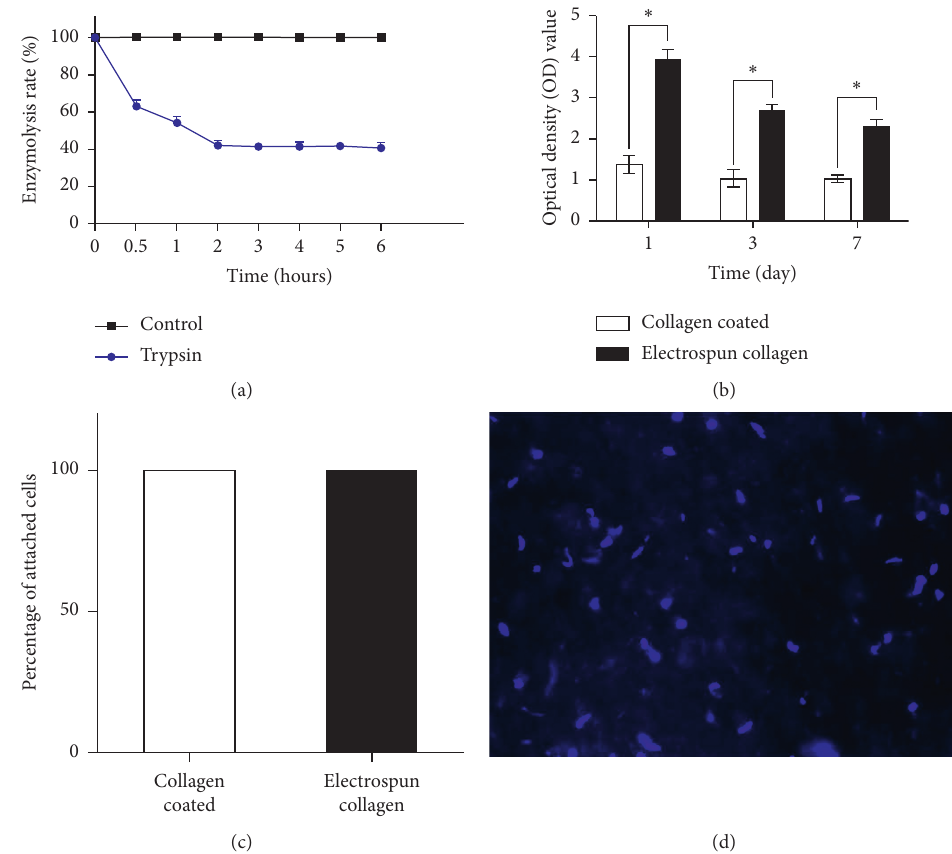
Figure 6: (a) Degradation test of electrospun collagen scaffolds treated with 0.25% trypsin by calculating the percentage of weight loss. Phosphate buffered saline alone was used as a control. (b) Cytotoxicity assay of human adipose tissue-derived mesenchymal stem cells cultured on cross-linked collagen electrospun nanofibers or collagen-coated culture dishes as a control group. (c) Cell adhesion test of human adipose tissue-derived mesenchymal stem cells (hAT-MSCs) seeded on cross-linked collagen electrospun nanofibers or collagen- coated culture dishes as a control group. (d) The live cells stained with Hoechst to show the distribution and adhesion of hAT-MSCs to scaffolds. Bar represents mean ± SD ( ∗ P < 0 . 05, N �